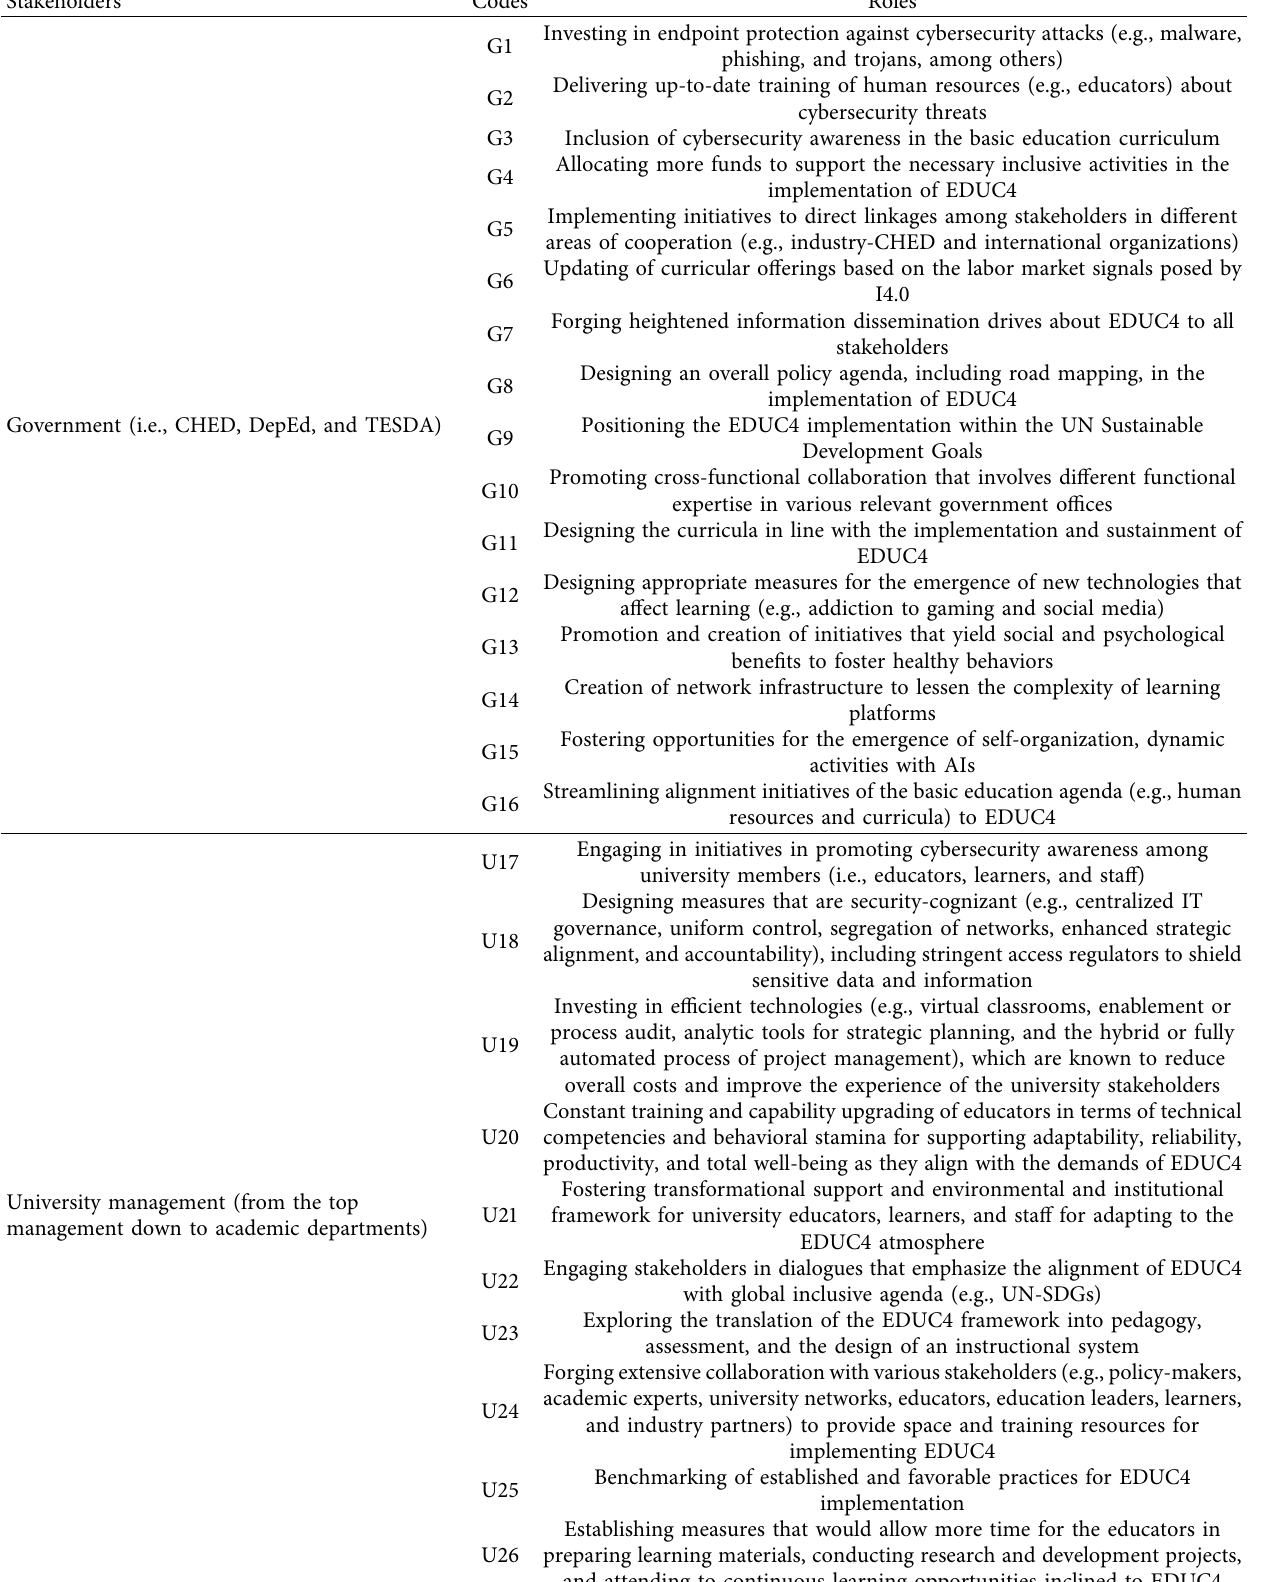
Table 1: Stakeholder roles in overcoming the barriers of EDUC4